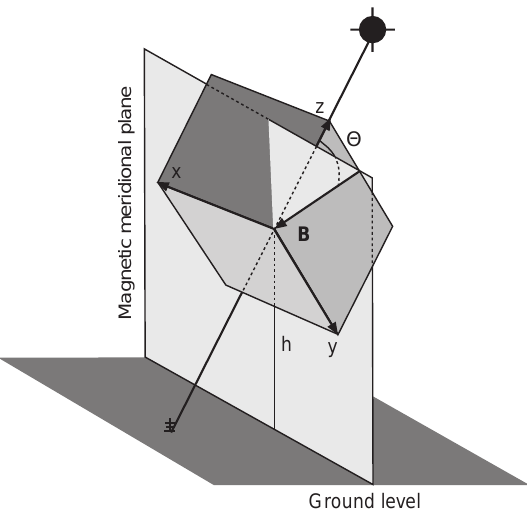
Fig. 1. The geometry and coordinate system for scintillation obser-